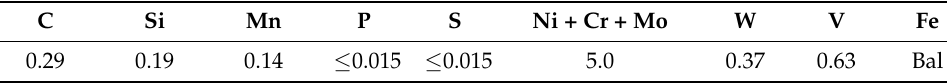
Table 1. Chemical composition of experimental materials